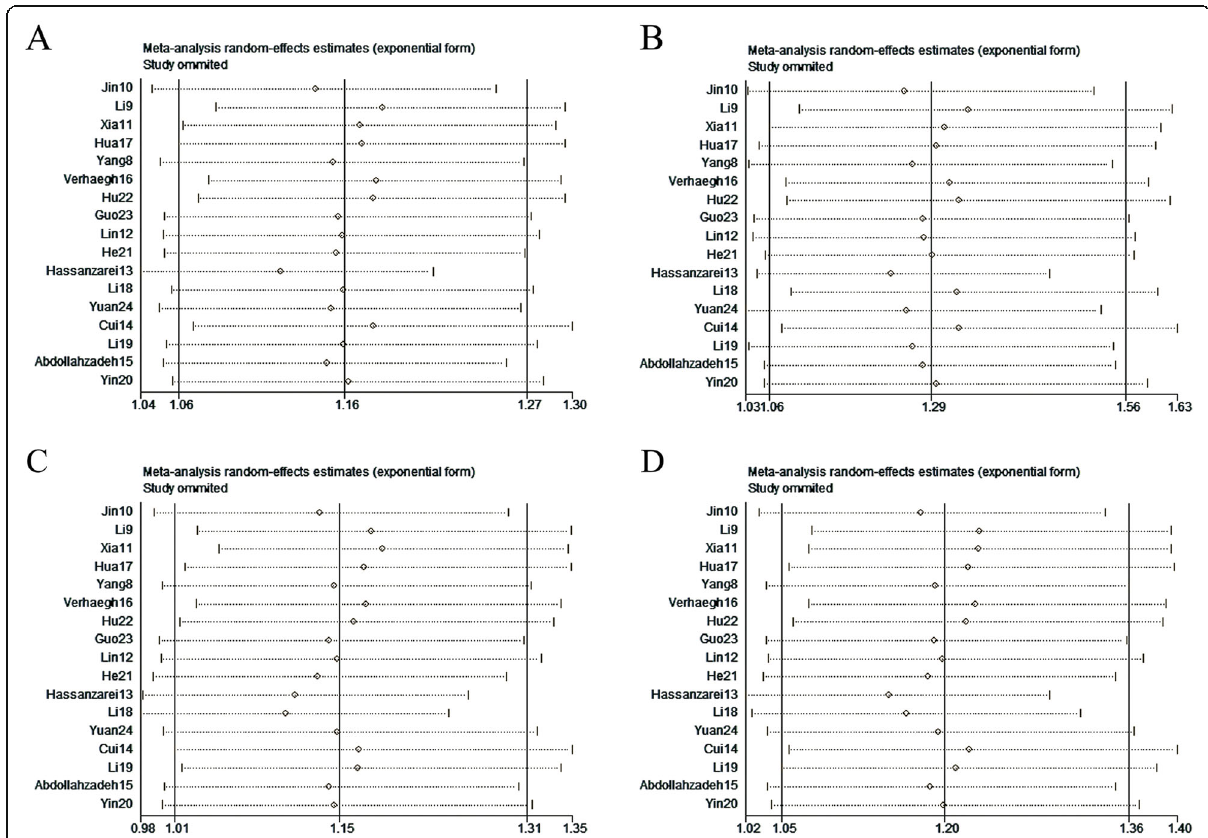
Fig. 4 Sensitivity analysis through deletion of one study at a time to reflect the influence of the individual dataset to the pooled ORs in H19 rs217727 polymorphism. a Allelic model (T vs. C), b homozygote model (TT vs. CC). c heterozygote model (CT vs. CC). d Dominant model [(CT + TT) vs.